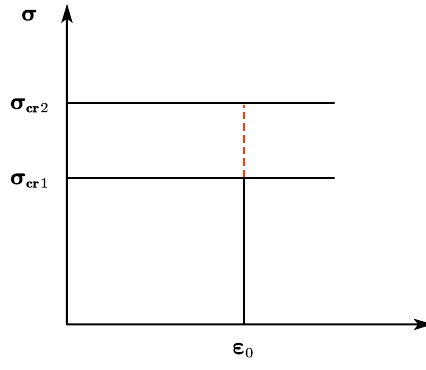
Figure 12. Schematic of the mechanical support.